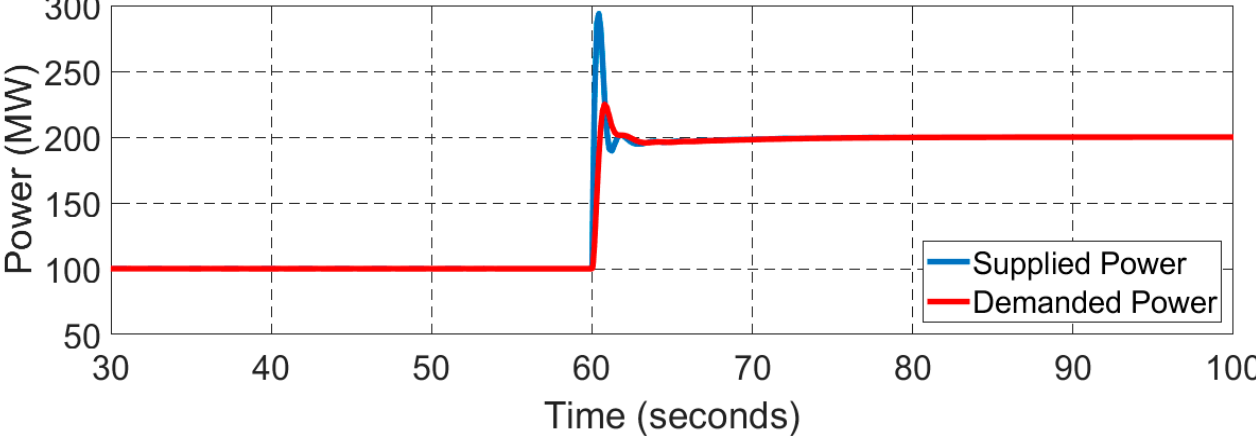
Figure 15. Step change load from 10% to 20% for a two-area PSN (Area 1): ( a ) frequency, ( b ) power.